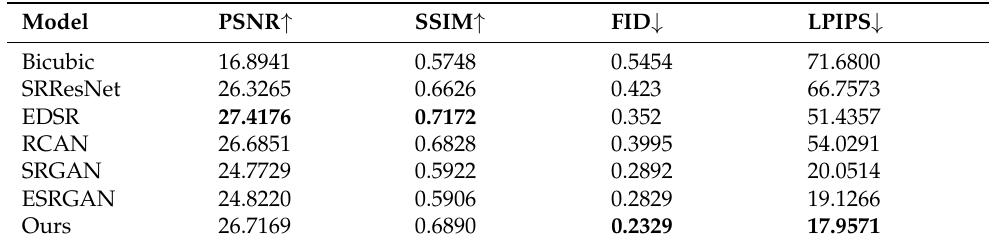
Table 4. Quantitative evaluation results for all methods in the dataset. The bold represents the best value for each